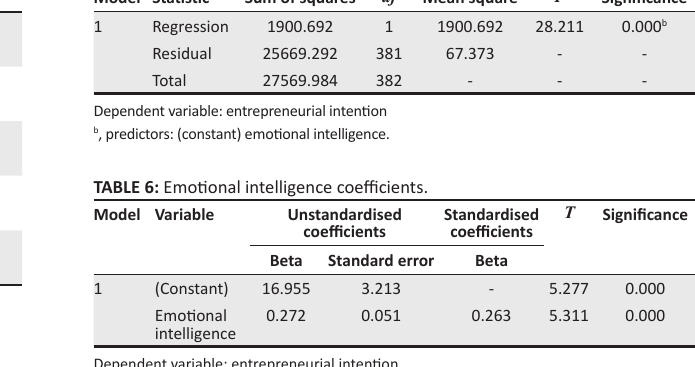
TABLE 3: Generalisations from the correlations. Hypothesis There is no relationship between emotional intelligence and entrepreneurial intention.